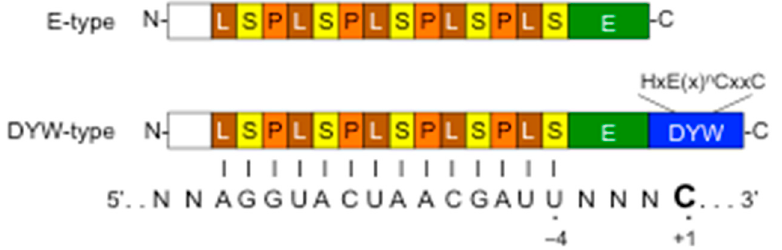
Figure 1. Plant organellar pentatricopeptide repeat (PPR) editing proteins and a model for their binding to the editing site. Schematic domain structure of PPR editing proteins that consist of PPR motifs (P, L, S), and additional C-terminal domains (E and DYW). The DYW domain contains the conserved zinc-binding motif signature, HxE(x) n CxxC. The PPR tract interacts with a target RNA in a one PPR motif to one nucleotide manner. The last PPR S motif recognizes nucleotide at position –4 from the editing site (+1).